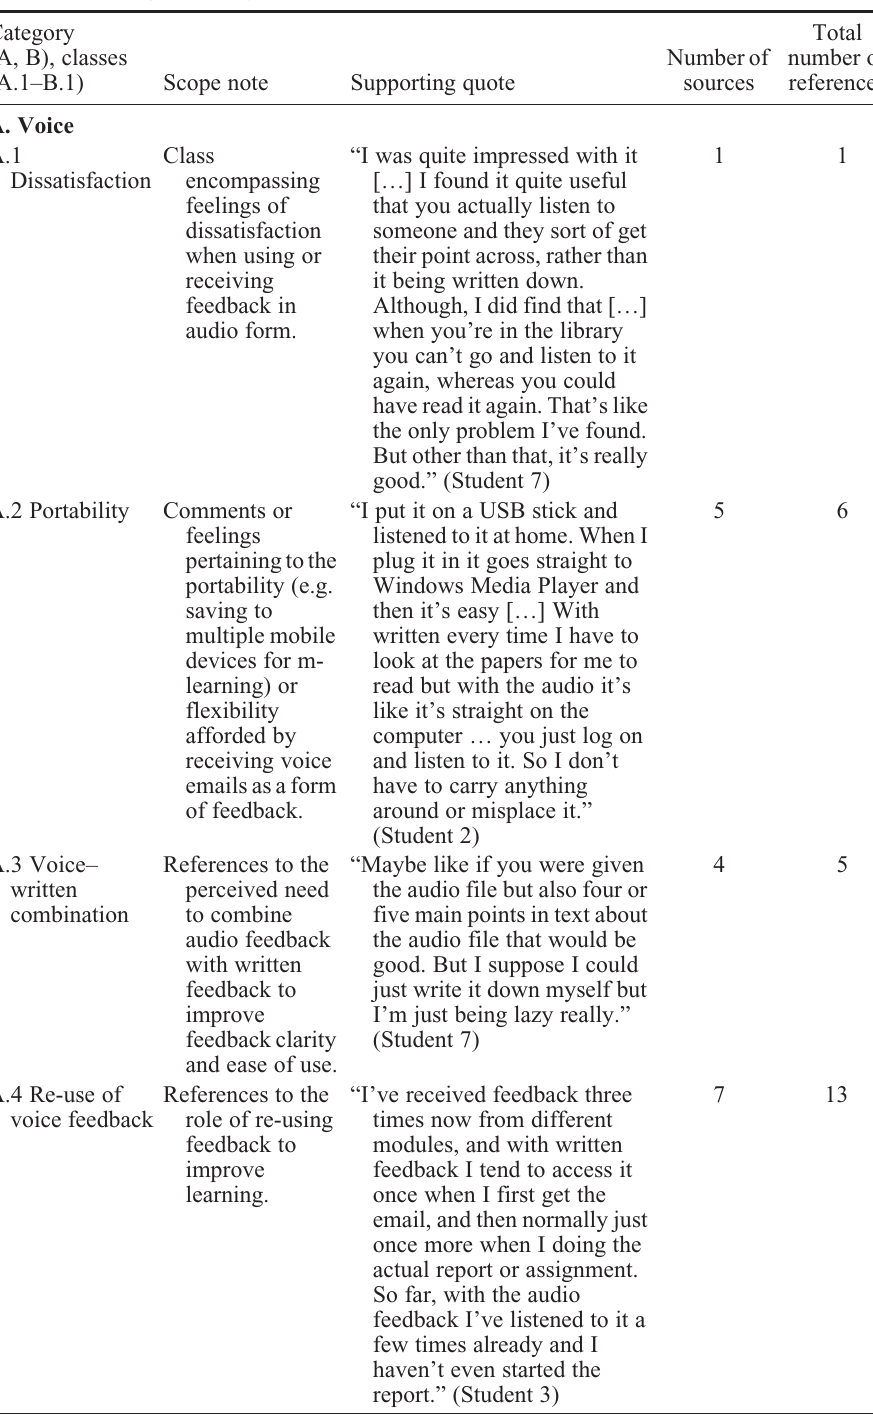
Table 7. Coding taxonomy derived from interview